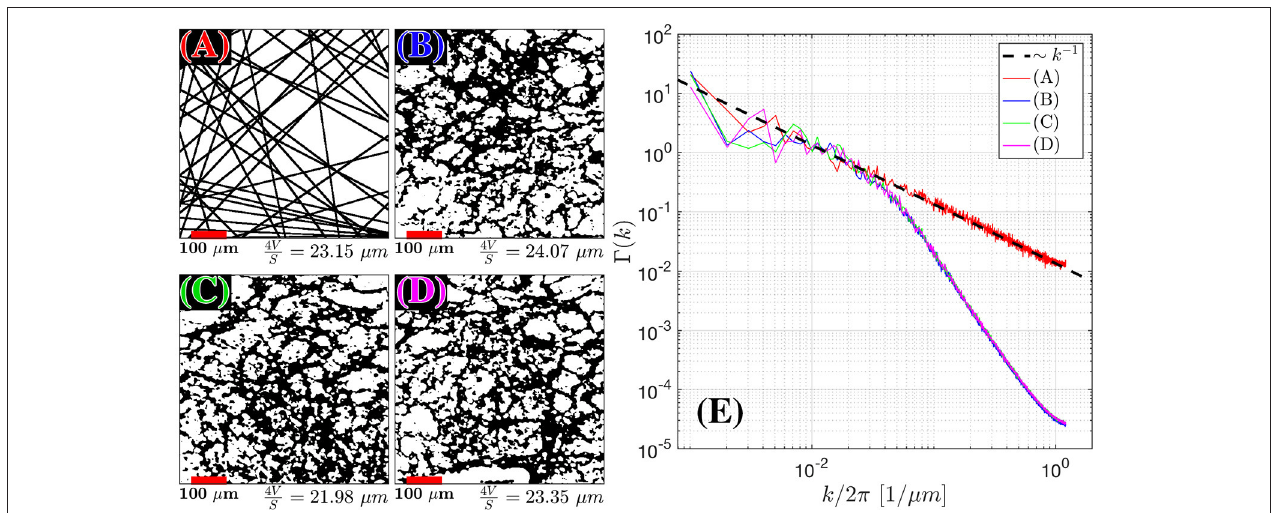
FIGURE 4 | Structural Correlation from histopathology. H&E stained samples of benign fibromuscular stroma from a radical prostatectomy were considered. In the body of the text, we found that extended disorder geometry, related to random membranes, defined the structural disorder for D C . We plot 55 randomly oriented ⊥ membranes in 2D (A) as an idealistic case for extended disorder and 3 samples (B–D) of segmented prostate fibromuscular stroma, which are predominantly taken through perpendicular cross sections. The segmentation was used to emphasize the cell walls as the primary sources of restriction to diffusion. The average length l / A for (B–D) , where l is the number of voxels found at the edge of each cell, and A is the area of scale from was determined by calculating S / V 2 l / A (A) and S / V = = the sample. The number of randomly oriented barriers in (A) was selected to match the average fiber diameter 4 V / S for the histological samples. For (A–D) the Fourier transform density autocorrelation function, Γ ( k ) was determined by radially averaging over k-space and plotting 1,200 bins from the 1,440 1,440 pixel 2 / 590 590 × × µ m 2 images (E) . The dashed black line represents the fit Γ( k ) Ak − 1 =